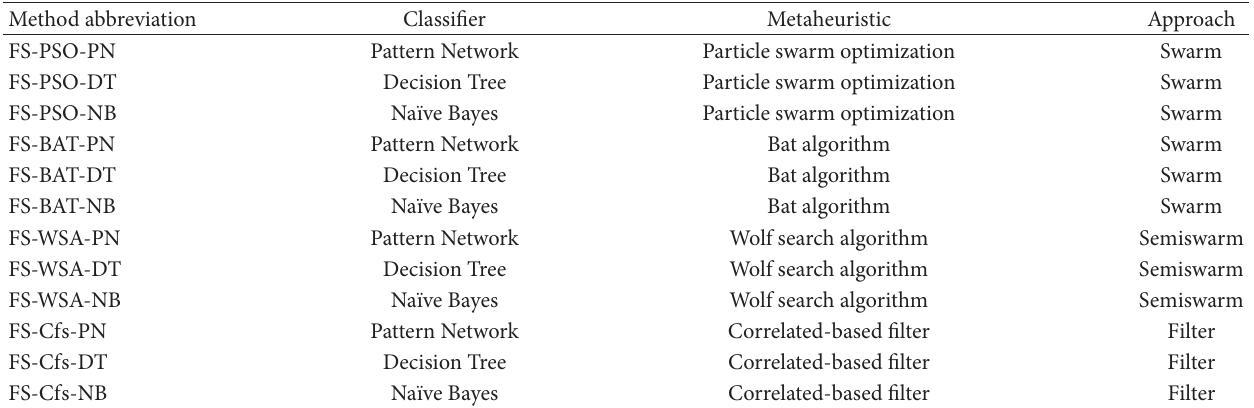
Figure 3: An illustration of possible moves of a search agent in the search space. Table 2: List of feature selection methods used in